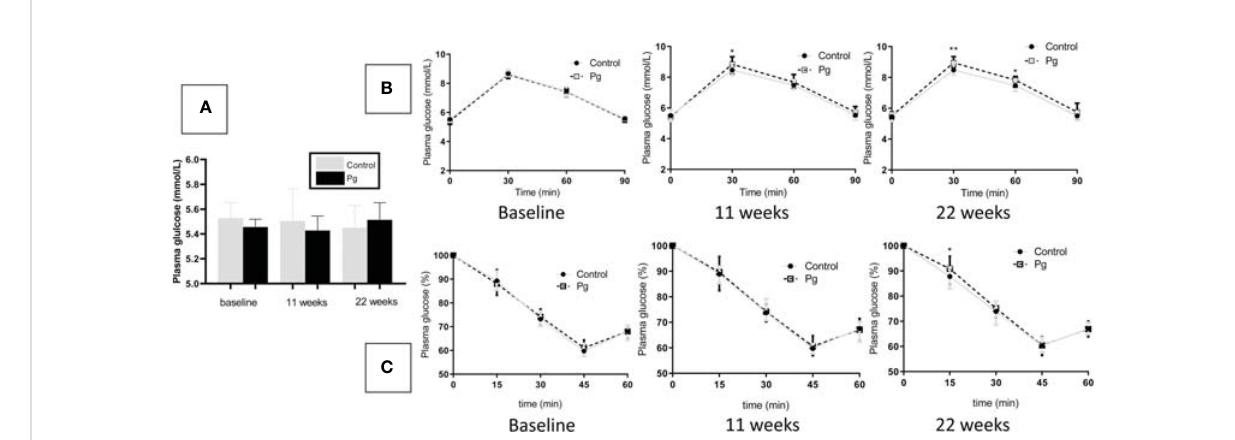
FIGURE 4 Effects of the oral administration of Porphyromonas gingivalis on fasting glucose, glucose tolerance, and insulin sensitivity. (A) Fasting glucose levels between the P. gingivalis -administered group and the control group at baseline, 11 weeks, and at 22 weeks after P. gingivalis infection. (B) Plasma glucose levels during an intraperitoneal glucose tolerance test (GTT) following overnight (12 h) fasting at baseline, 11 weeks, and at 22 weeks after P. gingivalis infection. (C) Plasma glucose levels during an intraperitoneal insulin tolerance test (ITT) following 4 h of fasting at baseline, 11 weeks, and at 22 weeks after P. gingivalis infection. * p < 0.05, ** p < 0.01. N = 6. Data are expressed as the mean ±